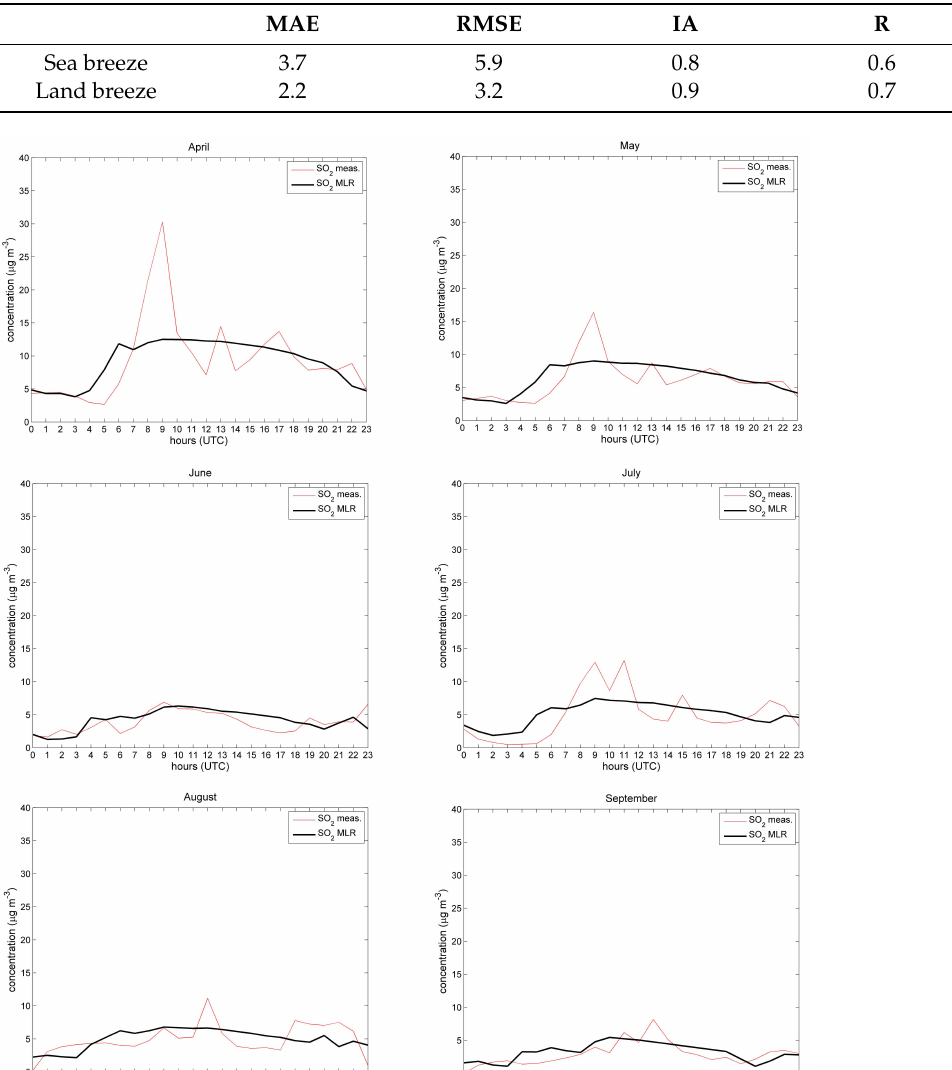
Table 4. Results of the stepwise multiple linear regression model are compared with the hourly measurements of SO 2 concentration( µ g m − 3 ) and with the mean absolute error (MAE), root mean square error (RMSE), index of agreement (IA), and correlation coefficient (R) for the sea breeze and land breeze separately at the AMS 3 Split-1 station.